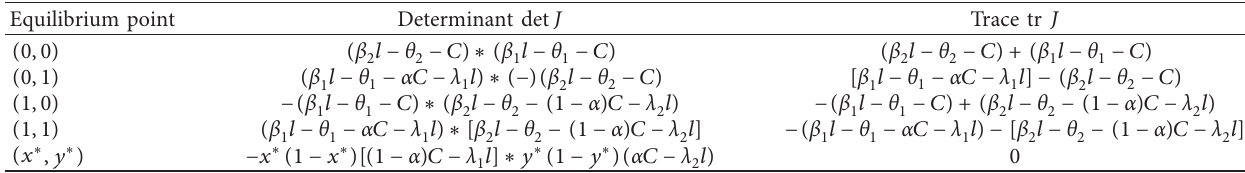
Table 3: The determinant det J and trace tr J of equilibrium point.